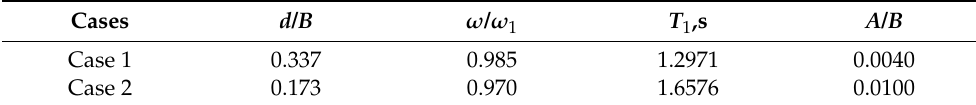
Figure 5. Dimensions of the water tank. Table 1. Experimental parameters.